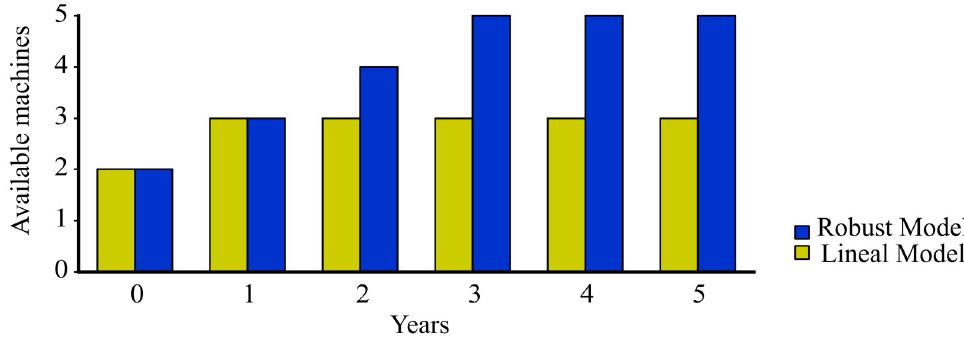
Fig 5. Machinery configuration of the proposed models.